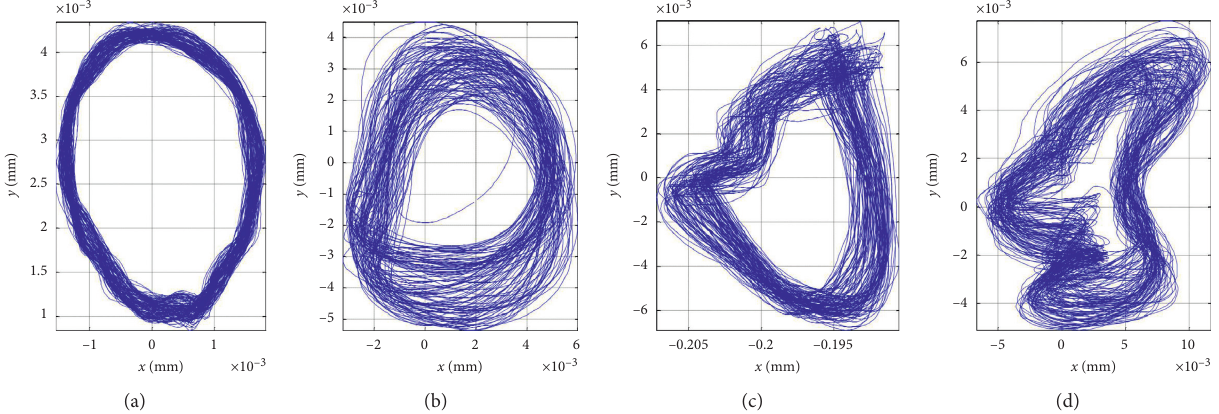
Figure 8: Axis orbits of the spindle at 1000r/min. (a) Condition 1. (b) Condition 2. (c) Condition 3. (d) Condition 4.